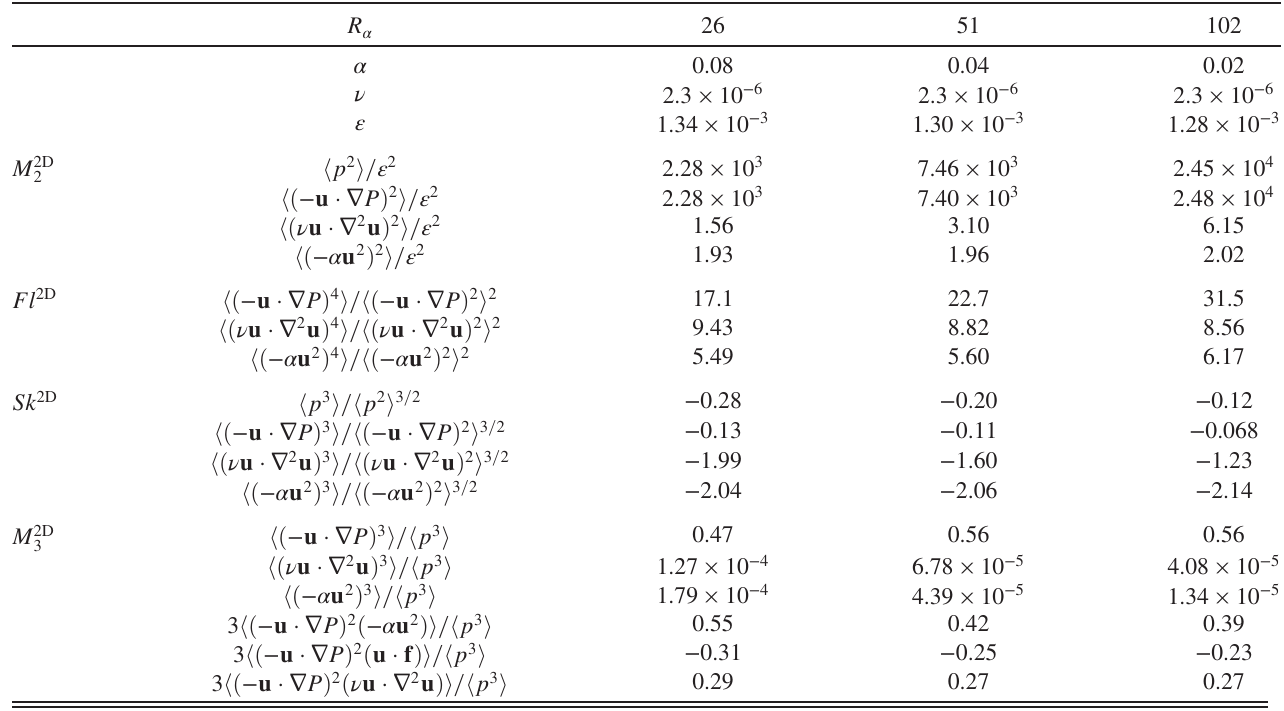
TABLE I. Second and higher moments of terms in Eq. (3) in 2D turbulence. Parameters in the simulation: α is the friction factor, ν is the viscousity, and ε is the flux of energy in the inverse cacade. Row M 2 D 2 : Second moments of p , − u · ∇ P , ν u · ∇ 2 u , and − α u 2 , all made dimensionless by the energy flux ε . Row Fl 2 D : Flatnesses of − u · ∇ P , ν u · ∇ 2 u , and − α u 2 . Row Sk 2 D : Skewnesses of p , h p 3 i from the pressure term, the viscous term, the friction − u · ∇ P , ν u · ∇ 2 u , and − α u 2 . Row M 2 D 3 : Contributions to the third moment term, and the three leading cross-correlation